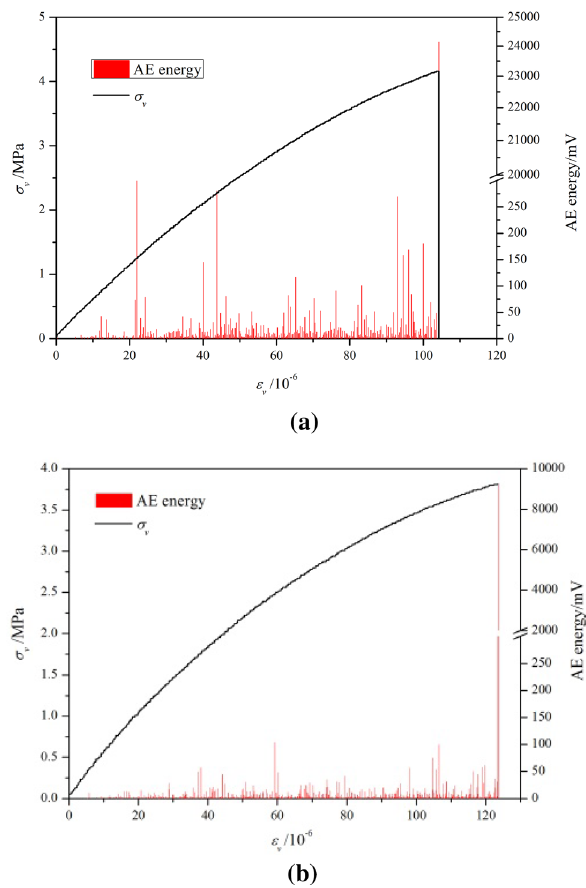
Fig. 4 AE activities during the whole directly tensile process for specimens in A group. a Specimen A1, b specimen